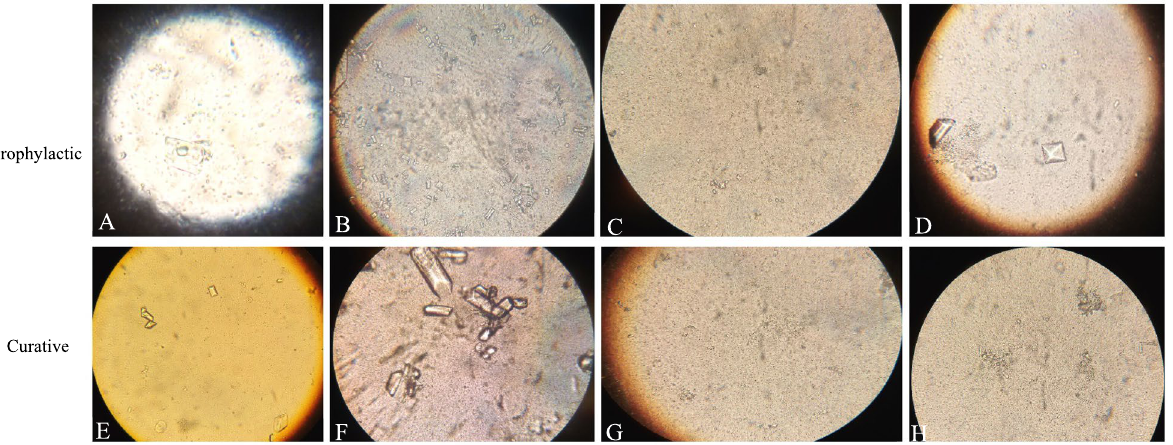
Fig. 4 Light microscopy of calcium oxalate crystals in urine. Prophylactic groups ( A – D ), curative groups ( E – H ) represent control, urolithiasis, LACTN, and cystone,